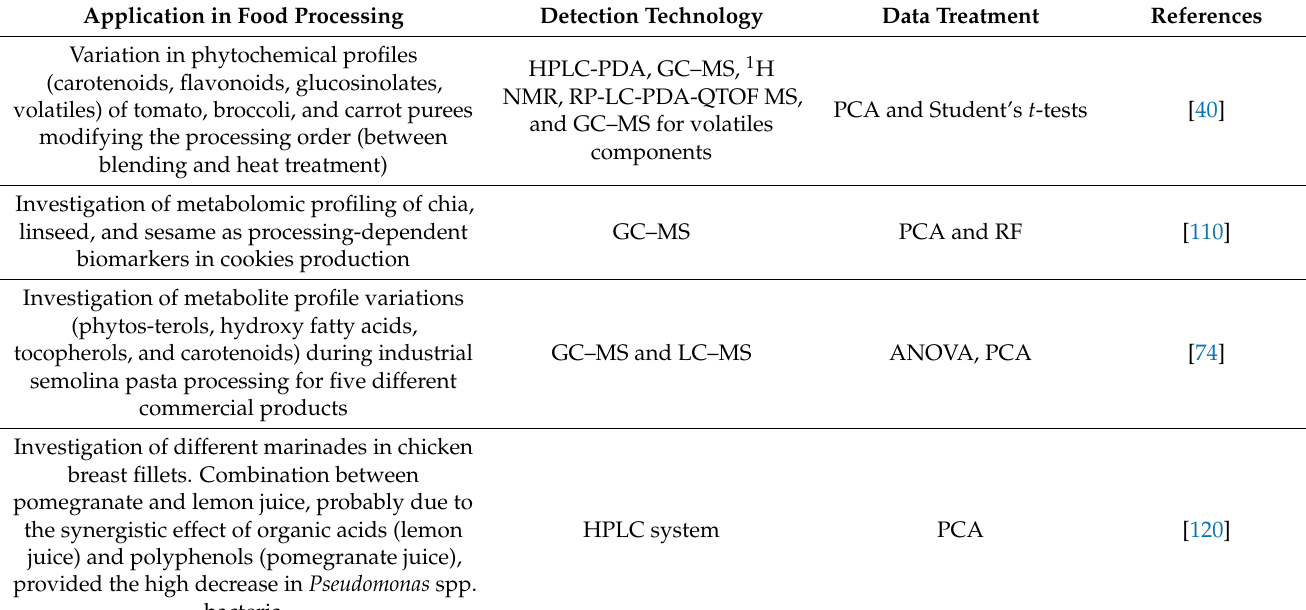
Table 3. Examples of metabolomic approach in food processing in